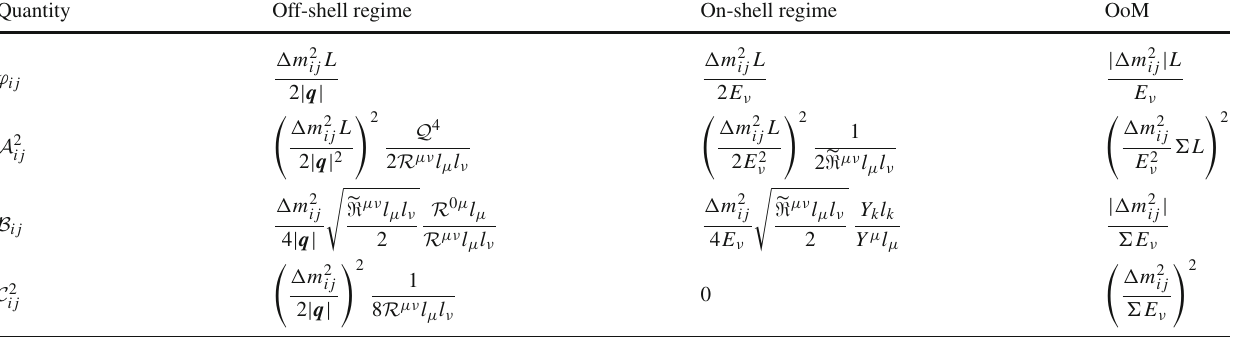
Table 1 Ingredients of Eq. (62) in leading order for off-shell (short dis- tances) and on-shell (long distances) regimes; the latter are taken from Ref. [28]. Here L = | y − x | and (cid:21) m 2 Quantity Off-shell regime On-shell regime